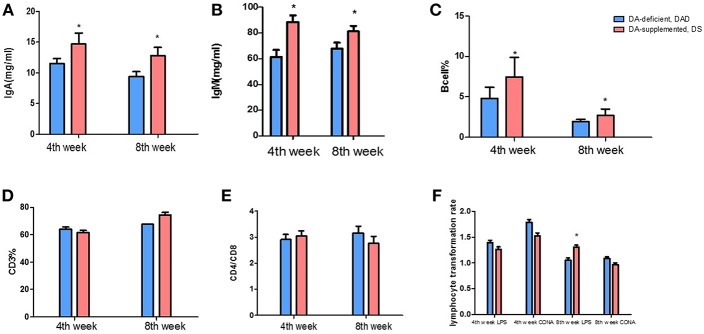
Effects of dietary daidzein supplementation of hens on the serum immunoglobulin levels and peripheral blood lymphocyte classification and lymphocyte proliferation. (A) Serum immunoglobulin A levels of hens at the 4 and 8th weeks of the experiment. (B) Serum immunoglobulin M levels of hens at the 4 and 8th weeks of the experiment. (C) Peripheral blood B lymphocyte percentages of hens at the 4 and 8th weeks of the experiment. (D) Peripheral blood CD3(+) T cell percentages of hens at the 4 and 8th weeks of the experiment. (E) Peripheral blood CD4/CD8 T cells of hens at the 4 and 8th weeks of the experiment. (F)
In vitro lymphocyte proliferation in hens at the 4 and 8th weeks of the experiment. Data information: We induced T and B lymphocyte cell multiplication in peripheral blood lymphocytes through concanavalin A and lipopolysaccharide stimulation, respectively. LPS, lipopolysaccharide stimulus index; CON A, concanavalin A stimulus index. The results are expressed as the means ± SEMs. Bars labeled with “*” are significantly different (P < 0.05).